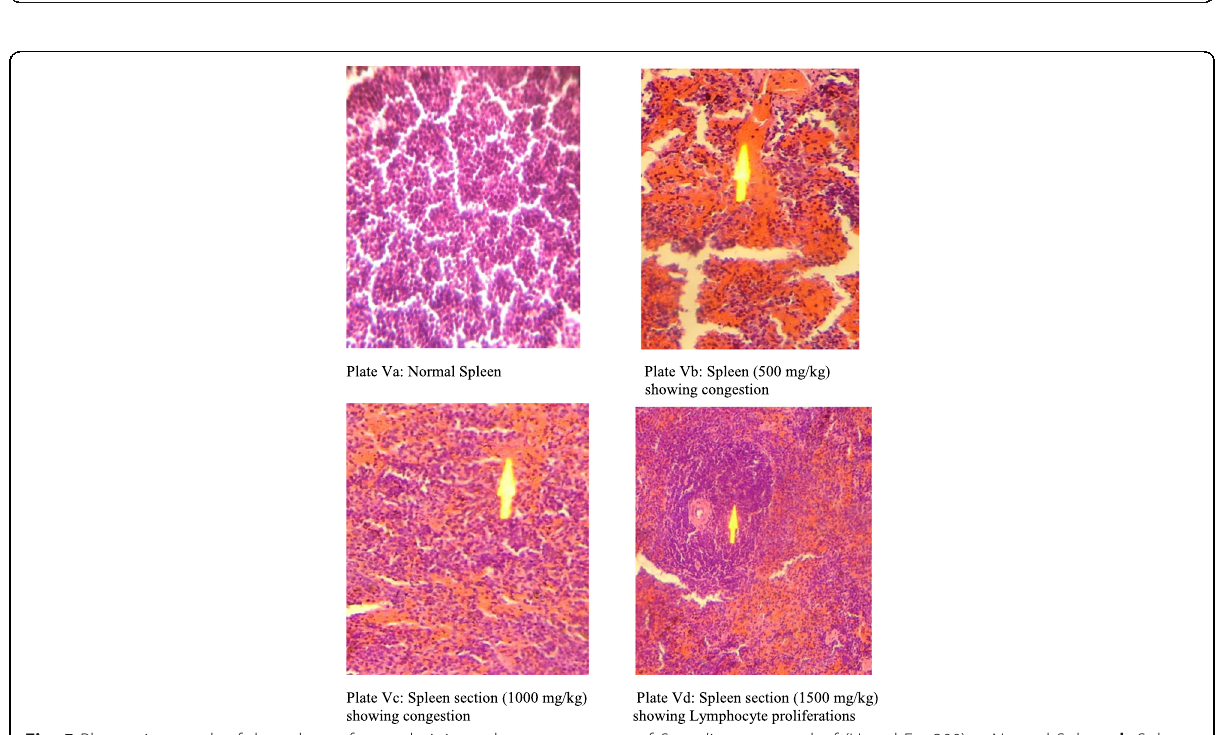
Fig. 4 Photomicrograph of the kidney of rats administered ethanol extract of Spondias purpurea leaf (H and E × 200). a Normal Kidney. b Kidney (500 mg/kg) showing congestion. c Kidney (1000 mg/kg) showing widened Bowman ’ s space. d Kidney (1500 mg/kg) showing adhesion of the parietal layer of glomerulus to the Bowman ’ s